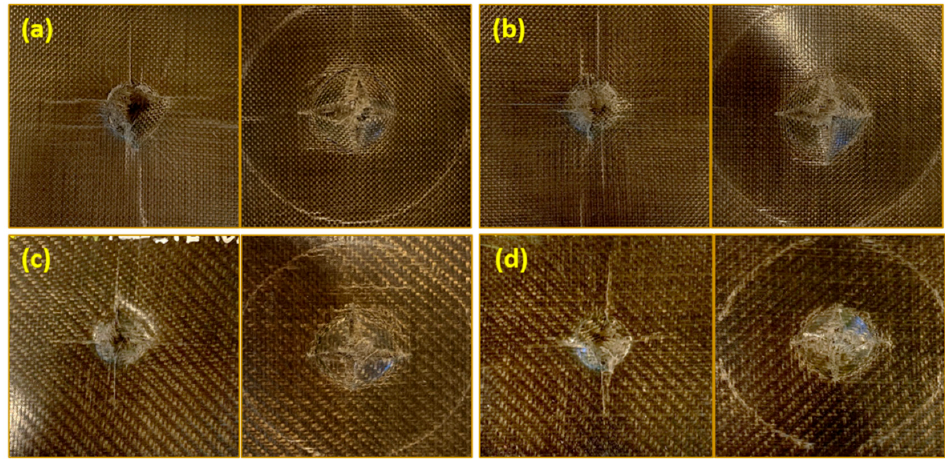
Figure 6. Pictures of the front (left) and rear (right) surfaces of the impacted Plane_TL ( a ), Plane_P40 ( b ), Twill_TL ( c ), and Twill_P40 ( d ) specimens.